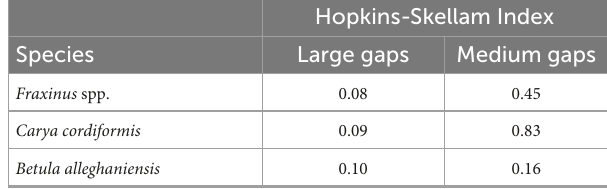
TABLE 4 Hopkins-Skellam Index scores for large and medium